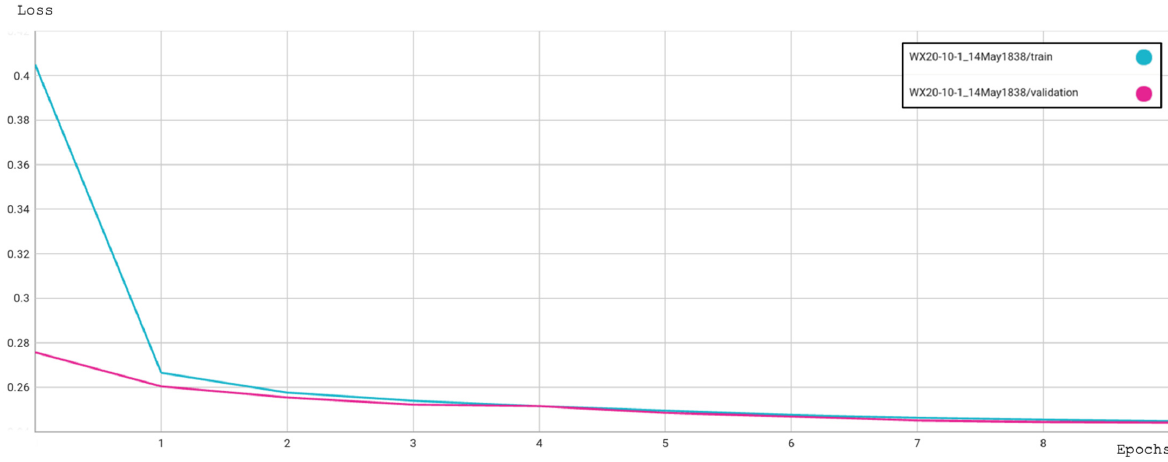
Figure 7. Weather events: model loss.